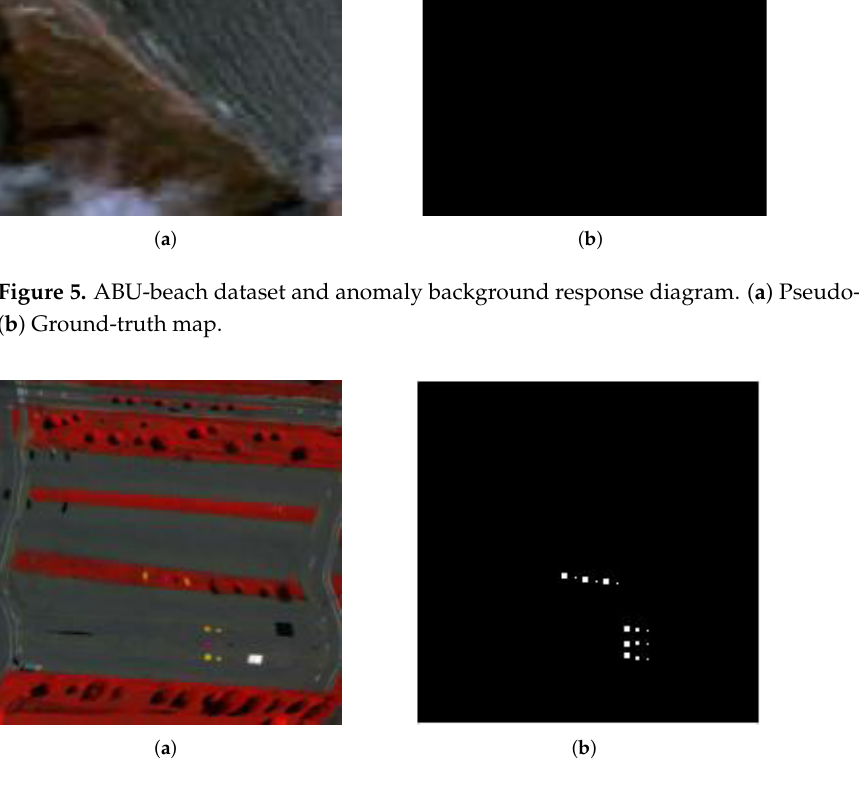
Figure 6. SpecTIR dataset and anomaly background response diagram. ( a ) Pseudo-color image. ( b ) Ground-truth